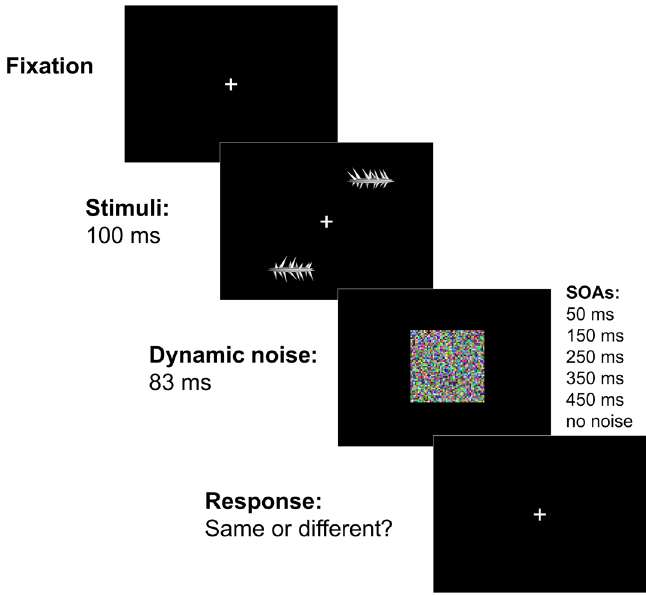
Figure 1. Schematic of a trial in the experiment. Two spikey objects were presented for 100 ms in the periphery of the visual field in diagonally opposite quadrants. A dynamic noise mask patch appeared in fovea for 83 ms at 5 different SOAs: 50, 150, 250, 350 and 450